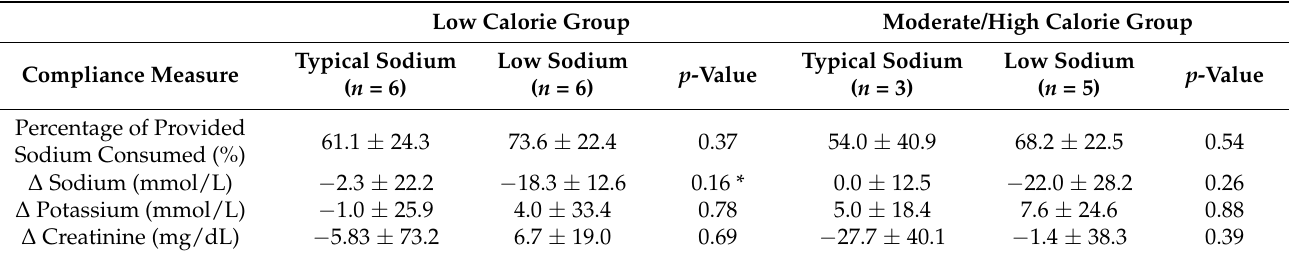
Table 4. Self-reported and urinary compliance by meal plan and calorie group. Low Calorie